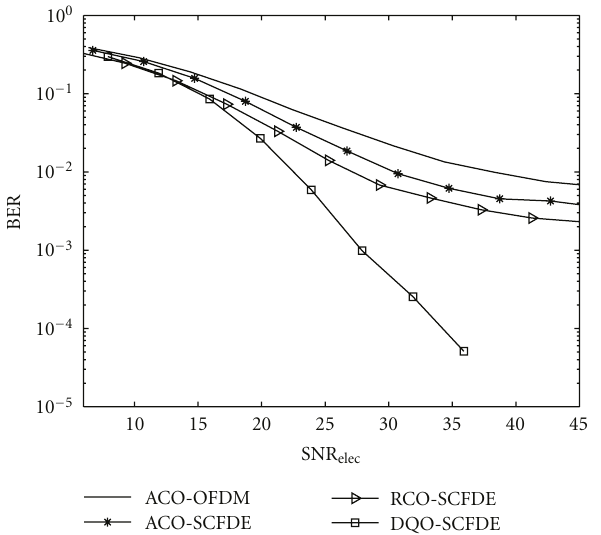
Figure 14: MMSE BER comparison of ACO-OFDM, ACO-SCFDE, RCO-SCFDE, and DQO-SCFDE with N = 64, 16 QAM input symbols with power 0.01 W, L = 3.